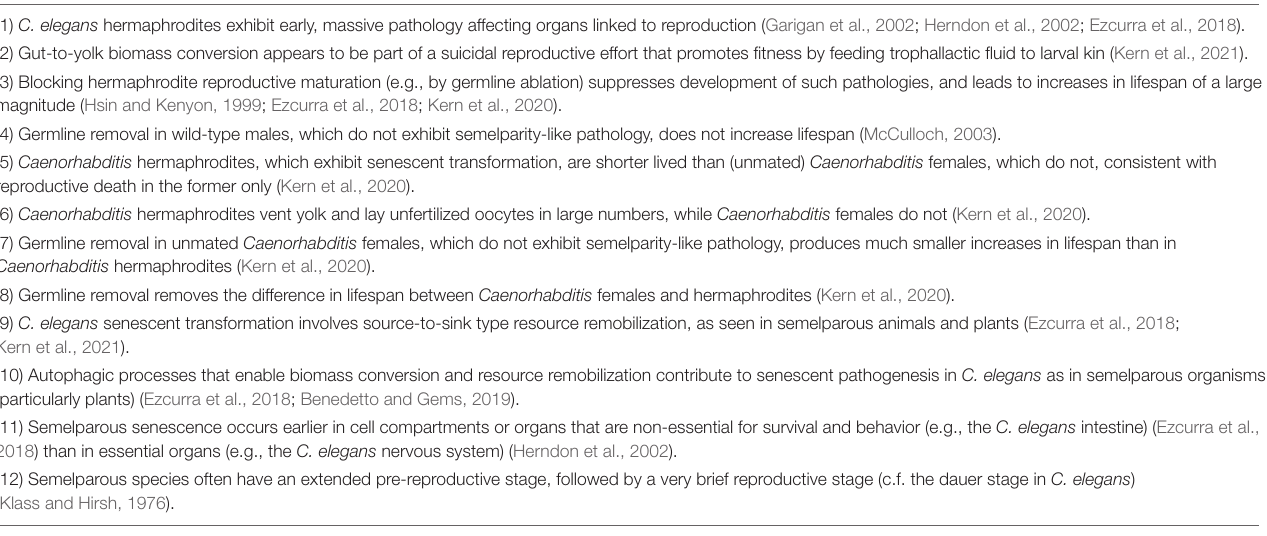
TABLE 2 | Features of C. elegans consistent with semelparous reproductive